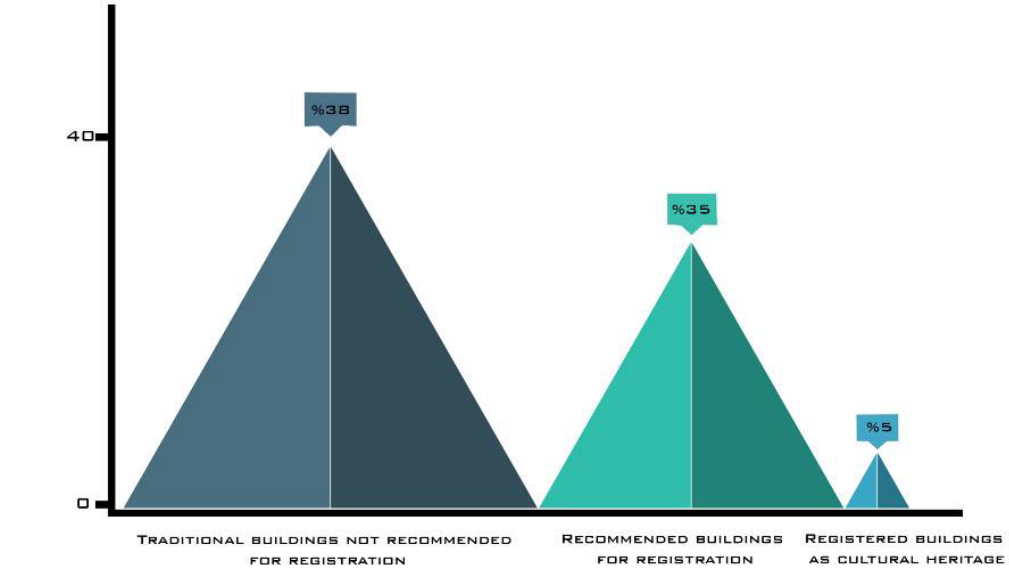
Figure 24 Diagram showing the ratio of the buildings registered as cultural property and proposed for registration (source: